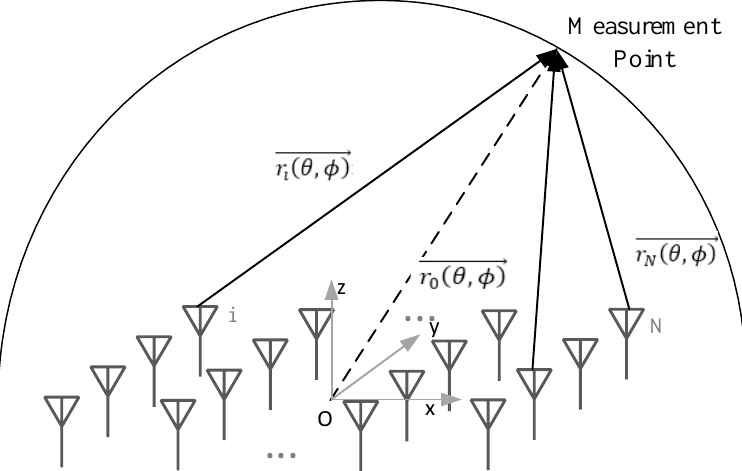
Figure 1. Schematic diagram of a N -element phased array. For a specific beam pattern, a theoretical weighted excitation matrix I at the element ports can be expressed as Equation (2), where N is the total number of elements. Equation (3) shows the relevance between the actual aperture excitation I ′ and the theoretical port excitation I , The difference between I ′ and I is defined as excitation coefficient C , which is determined by the non-ideal factors above, as shown in Figure 2.